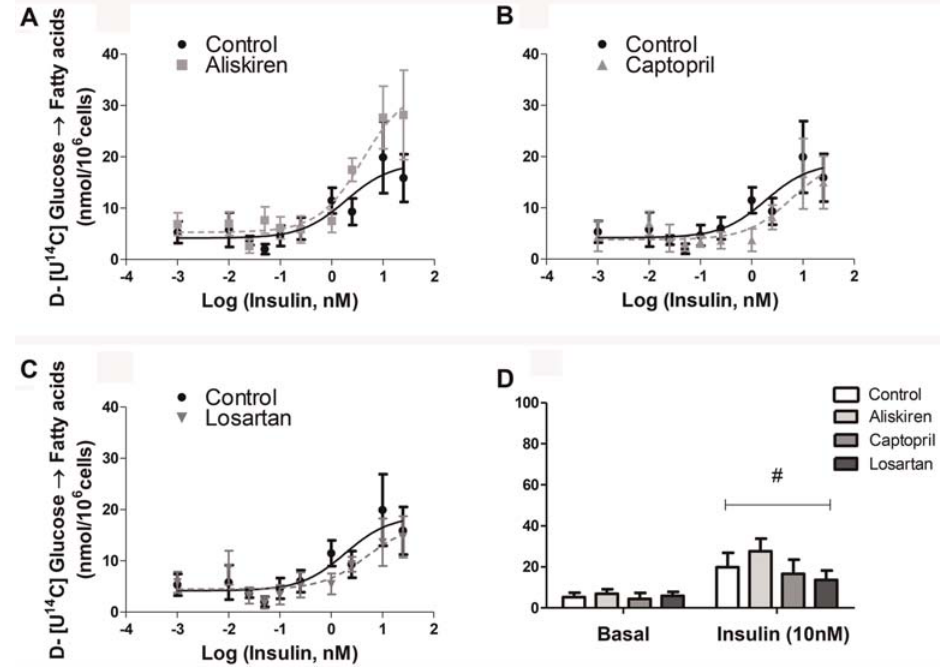
Figure 3. Fatty acids glucose incorporation of isolated fat cells previously treated with renin-angiotensin system blockers ( A ) aliskiren, ( B ) captopril and ( C ) losartan. There were no signi fi cant differences between treatments. Cells were incubated with increasing concentrations of insulin for 60 min at 37°C. D-[U- 14 C]-glucose (0.05 m Ci/tube) was added to the incubation medium at the beginning of the test. At the end, adipocyte lipid content was extracted, and the radioactivity incorporated in fatty acids was determined. D , basal and 10 nM insulin-stimulated lipogenesis ( # P o 0.001 for basal vs 10 nM insulin) Data are reported as the mean ± SE (n=6). Two-way ANOVA and the Bonferroni ’ s post hoc tests were